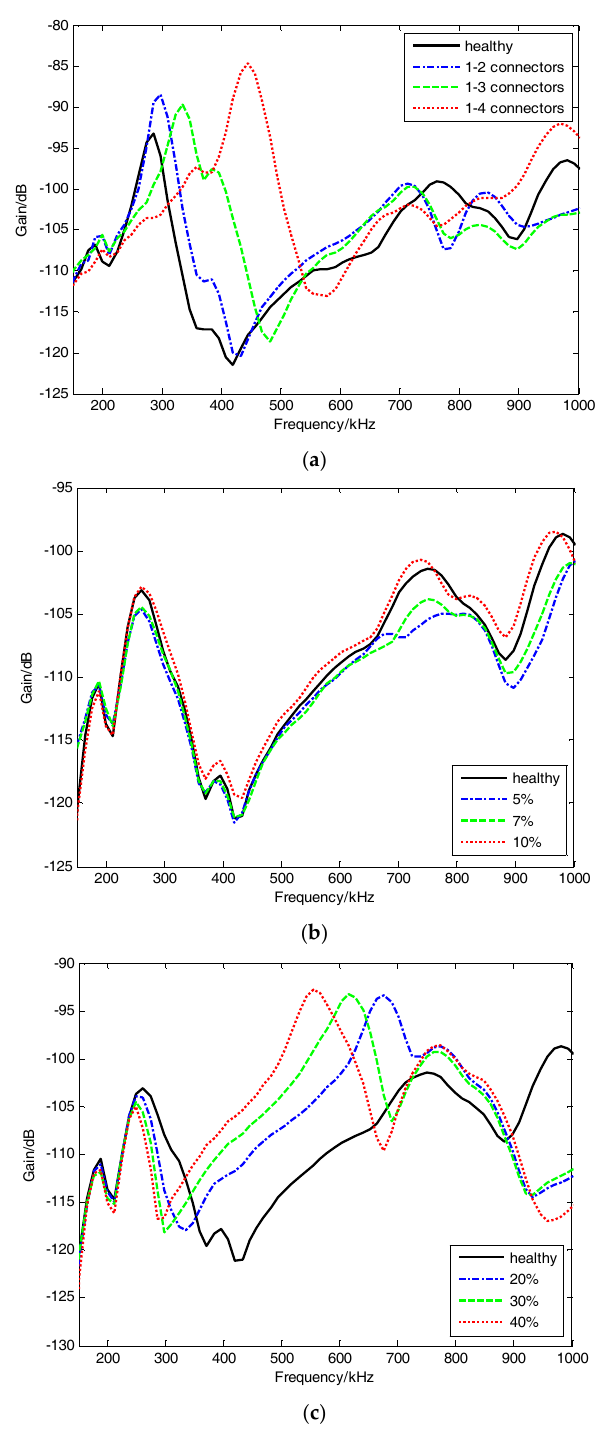
Figure 4. Some cases of experimental IFRA signatures under different simulated winding deformation faults: ( a ) simulated inter-disk SC fault; ( b ) simulated RD fault; ( c ) simulated DSV fault.